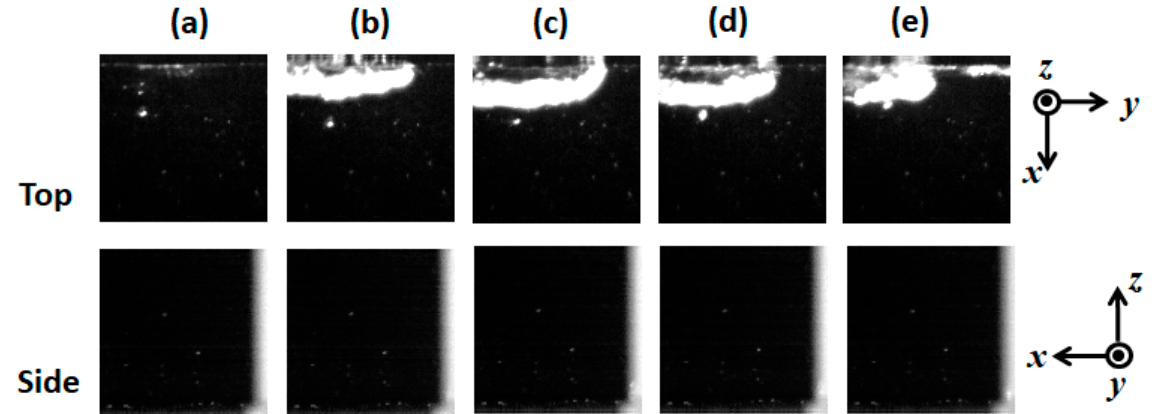
Figure 7. Instantaneous visualization using the synchronized signal with two high-speed cameras at a heat flux of 1.5 MW/m 2 : ( a ) 186.3 ms, ( b ) 186.6 ms, ( c ) 186.9 ms, ( d ) 187.1 ms, and ( e ) 187.3 ms.